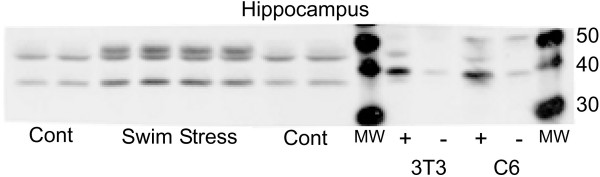
Swim stress did not induce phosphorylation of MKK3/6. Note the absence of a band for P-MKK3/6 at ~40 kD, either in control or swim stressed hippocampal lysates, whereas an induced band is visible in the positive control cell extracts. Also note the unknown ~37 and 48 kD proteins induced by swim stress. Other brain regions examined exhibited a similar pattern. 3T3, lysates of NIH/3T3 cells treated with (+) or without (-) UV radiation (40 mJ, 45 minutes recovery time); C6, lysates of C6 glioma cells treated with (+) or without (-) anisomycin (25 μg/ml, 30 min); MW, molecular weight markers.